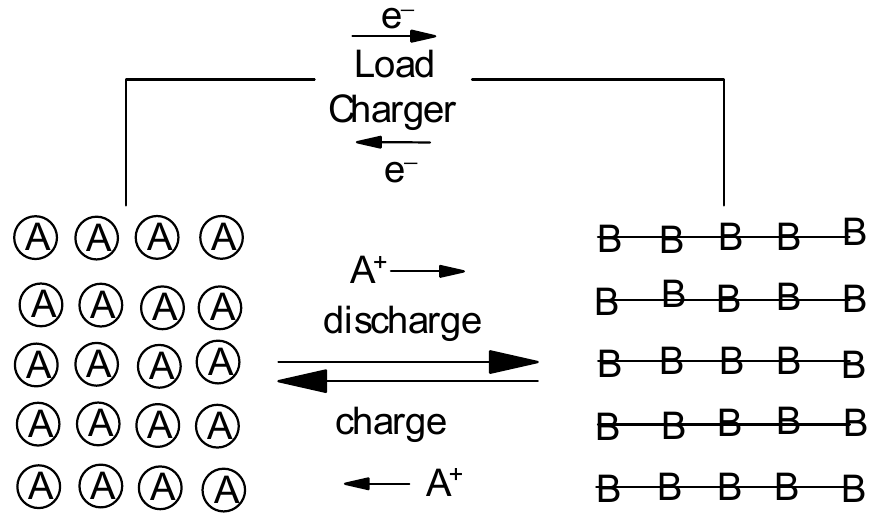
Figure 1. Principle of a rocking-chair battery, a positive intercalation-type electrode is assumed.